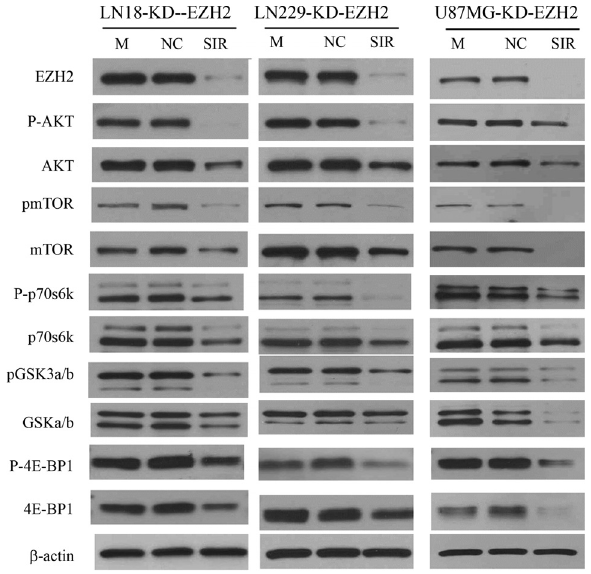
Figure 5 - EZH2 gene silencing attenuated the expression of proteins in- volved in the PI3K/Akt signaling pathway. M – blank control (mock), NC – normal control (cells with scrambled siRNA), SIR – cells treated with specific siRNA. The blots are representative of 3 experiments.